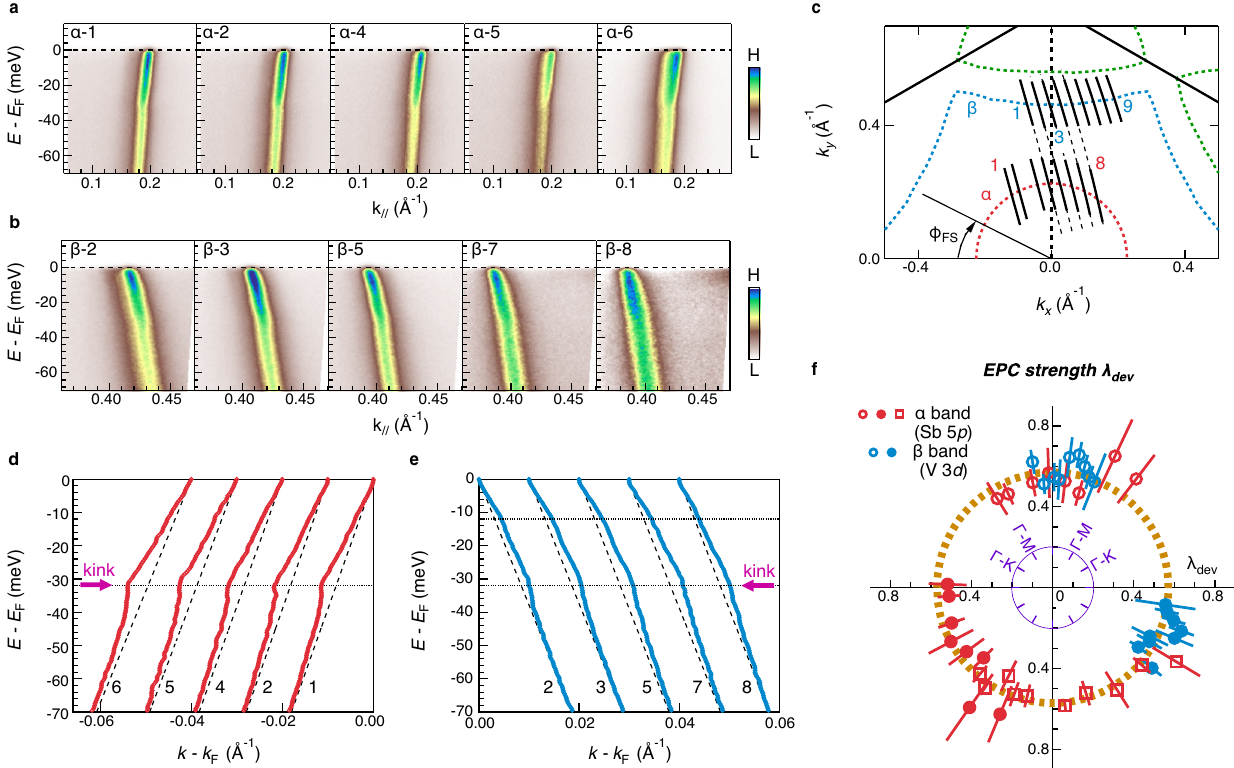
Fig.3|Momentumdependenceoftheelectronickink.a , b RepresentativeARPES intensity plots for the α and β bands as marked in c , respectively. d , e Extracted band dispersions for the representative α and β bands, respectively. The dashed black lines are bare bands. The red purple arrows indicate the 32-meV kink. These extracted dispersions are offset horizontally for a better view. f EPC strength λ dev de fi nedbytheslopeofRe Σ ( ω )at E F plottedwithFSangle ϕ FS asthehollowmarkers.